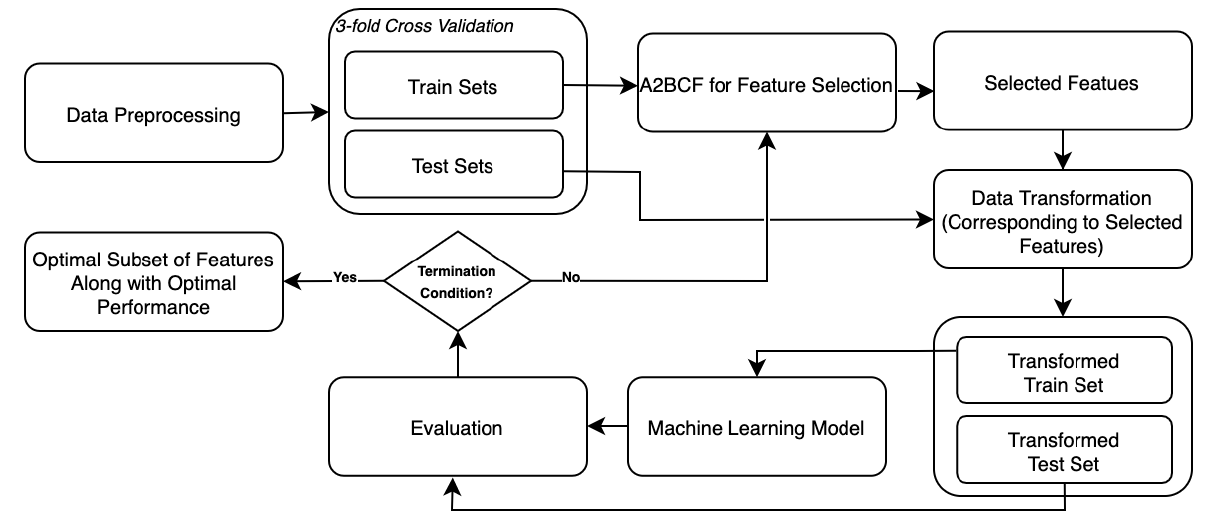
Figure 3. The overall structure of feature selection in this